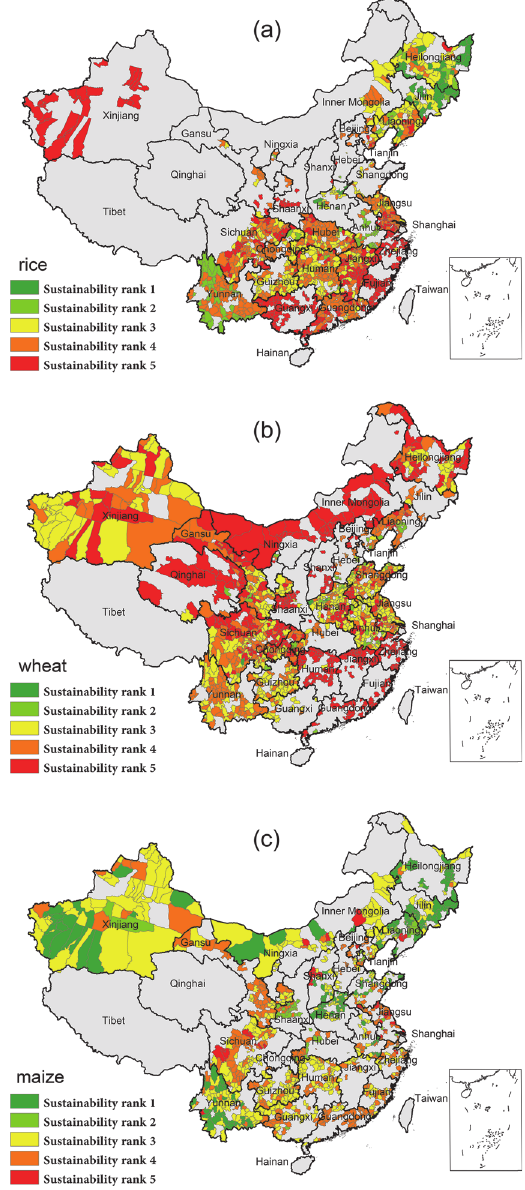
Fig 4. Pattern of the productivity sustainability for main cereals. Combining effects of both yield and area on production sustainability were color coded followed by the Tab.1 strategy.